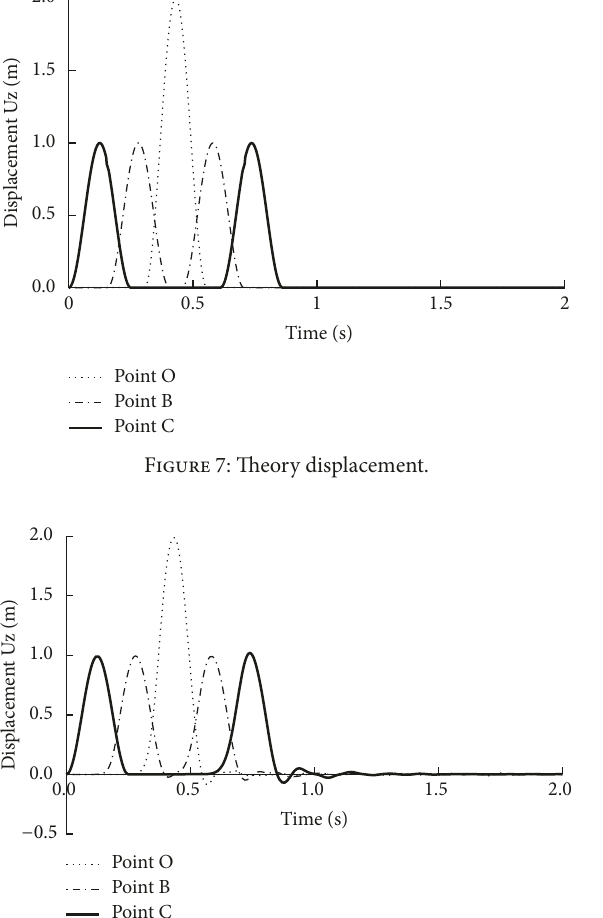
Figure 8: Numerical displacement of Method 1.